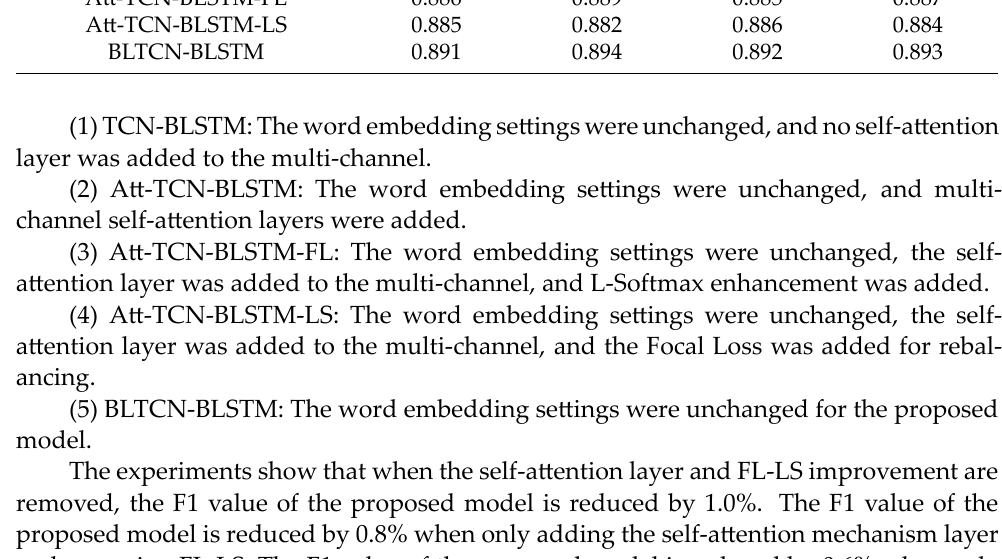
Table 6. Comparison of the ablation results of the models. Model